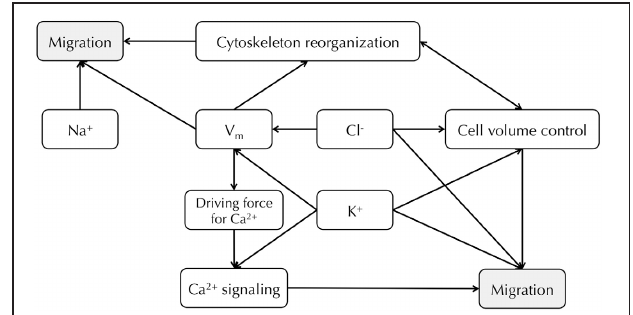
FIGURE 4 | Relationship between Na + , K + , Cl − channels and V m in cancer cell migration. V m provides the driving force for Ca 2 + , and downstream Ca 2 + signaling leads to cell migration (Schwab et al., 2012). V m also regulates cytoskeleton reorganization (Chifflet et al., 2003, 2004). Cl − and K + channels both contribute to V m regulation and cell volume control (Soroceanu et al., 1999; Sontheimer, 2008; Habela et al., 2009; Schwab et al., 2012). Inhibiting particular Na + , K + , and Cl − channels can reduce cancer cell migration (Sontheimer, 2008; Brackenbury, 2012; Schwab et al.,